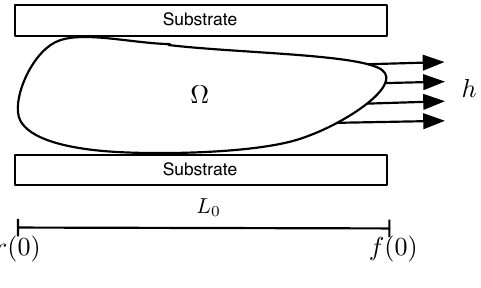
Figure 2. Scheme of the considered